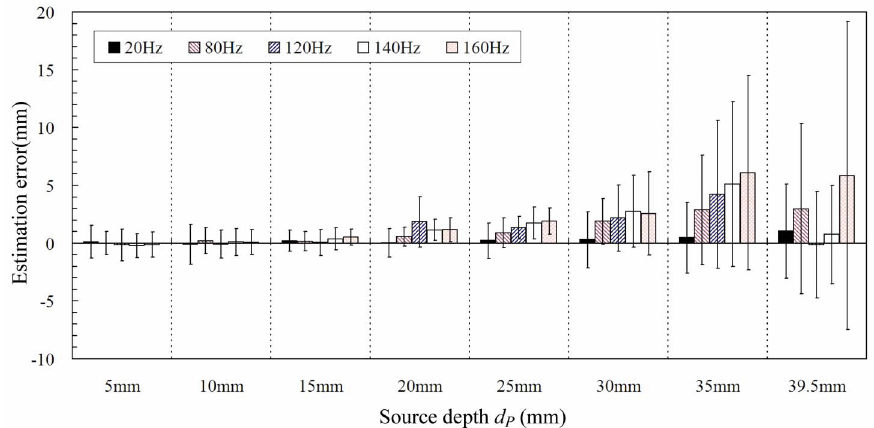
Fig. 6 Estimated depth error (averages of the five